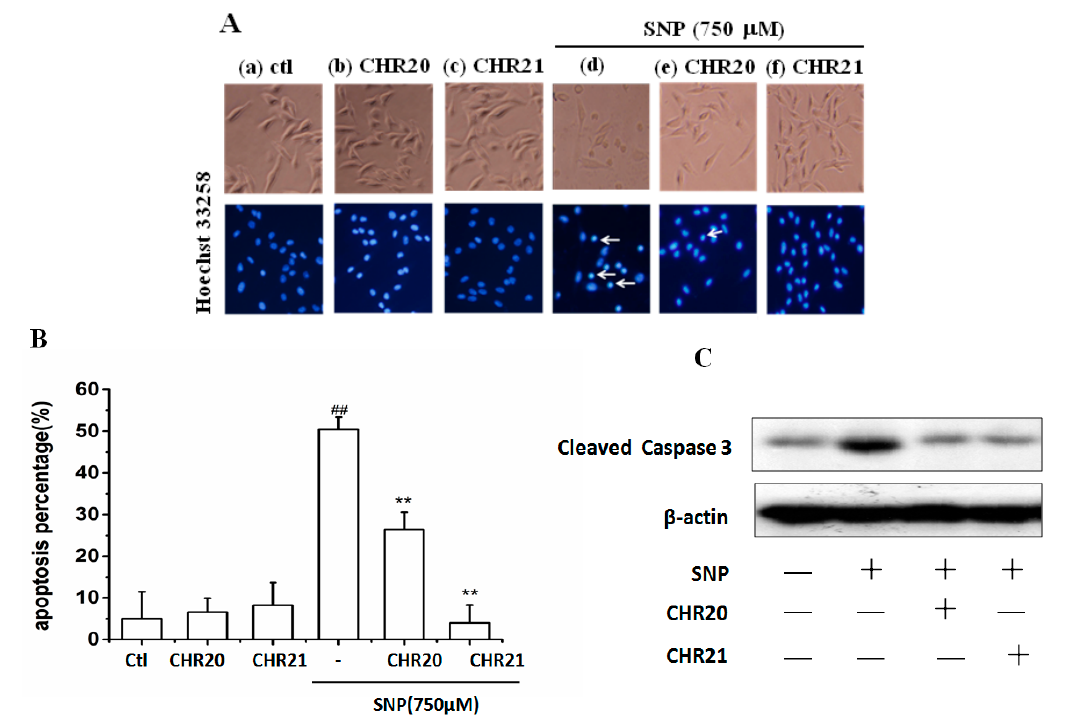
Figure 5. CHR20 and CHR21 protected RGC-5 cells from apoptosis induced by SNP. RGC-5 cells were pretreated with/without CHR20/CHR21 for 2 h, respectively, after treatment of 750 μ M SNP for 24 h and the cells were stained with Hoechst 33258 as described in Materials and Methods. ( A ) Morphological changes shown by fluorescence microscope (200×) image analysis. (a) control group; (b) 30 μ M CHR20 group; (c) 30 μ M CHR21 group; (d) 750 μ M SNP group; (e) 750 μ M SNP + 30 μ M CHR20 group; (f) 750 μ M SNP + 30 μ M CHR21 group. The arrow indicates nuclear fragmentation or